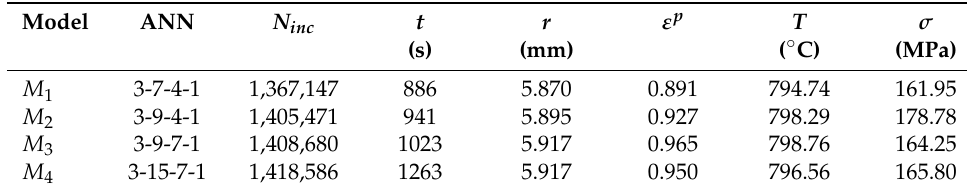
Table 2. Compression of a cylinder using the four ANN flow laws, results for the center element of the